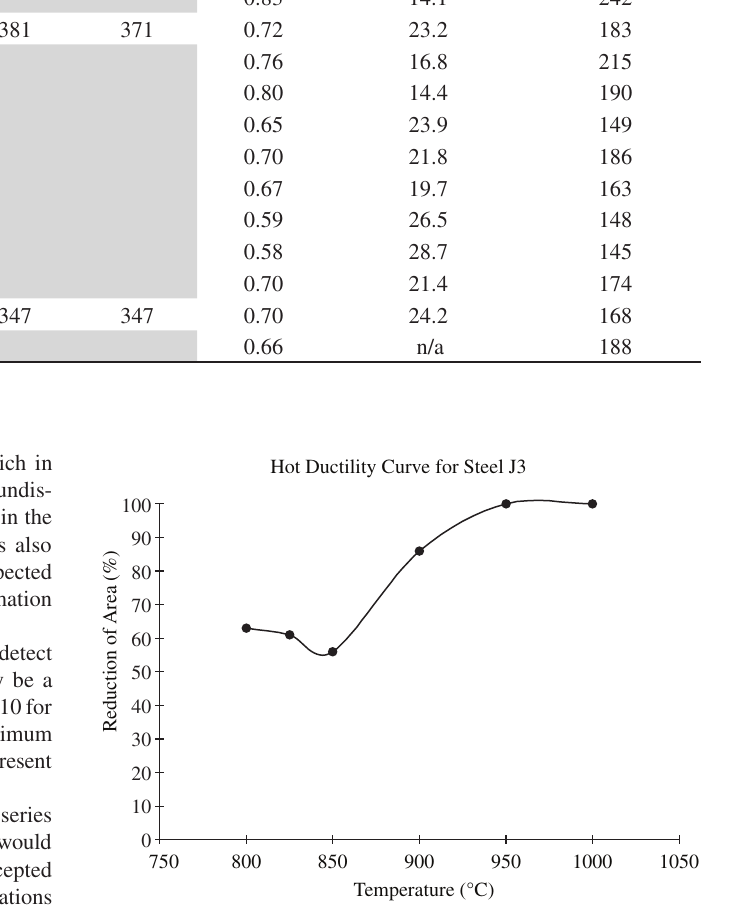
Figure 10. An example of the hot ductility test